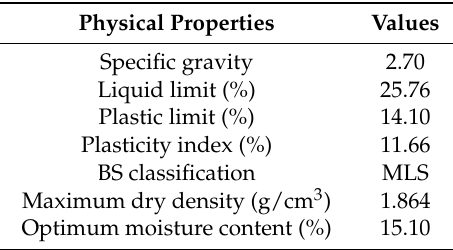
Table 1. Characteristics of the natural